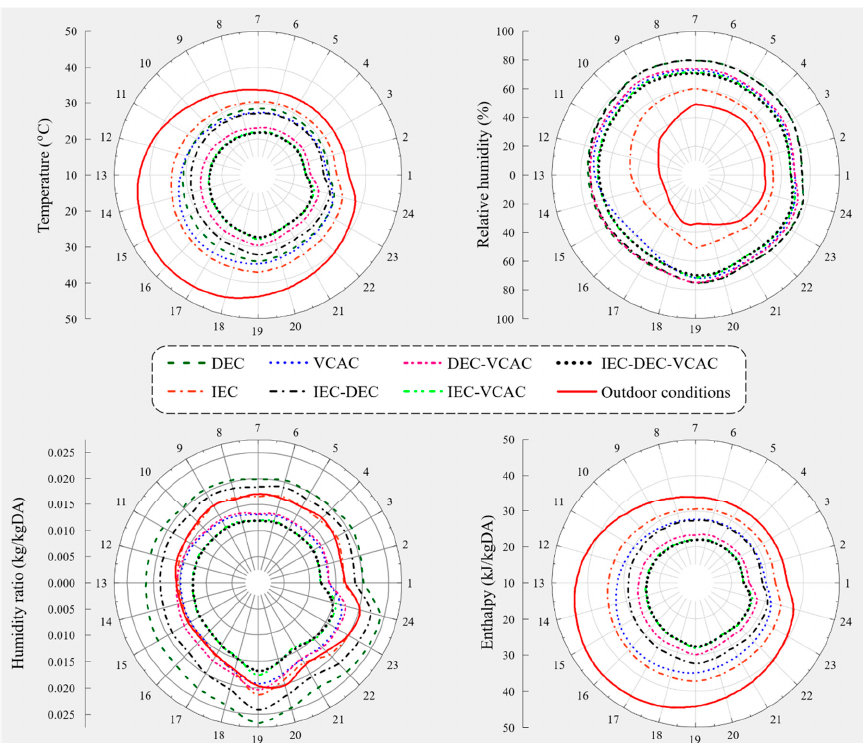
Figure 6. Performance evaluation on hourly basis for the proposed seven AC system configurations using climatic data of 19 June.